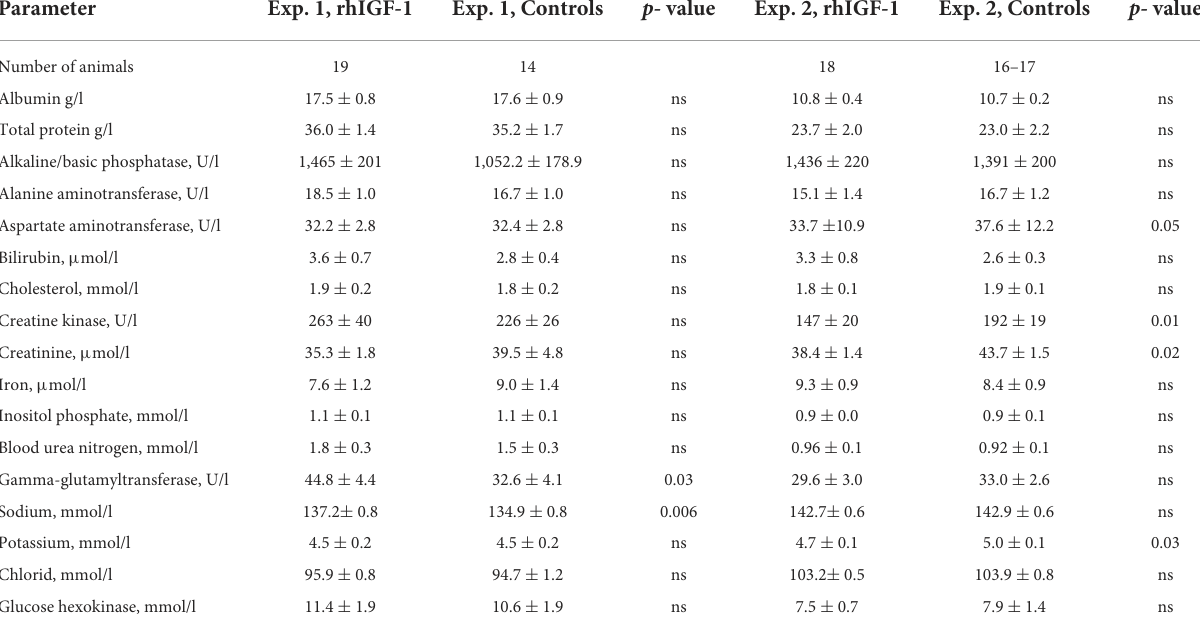
TABLE 2 Plasma biochemistry of preterm pigs treated with rhIGF-1 or vehicle